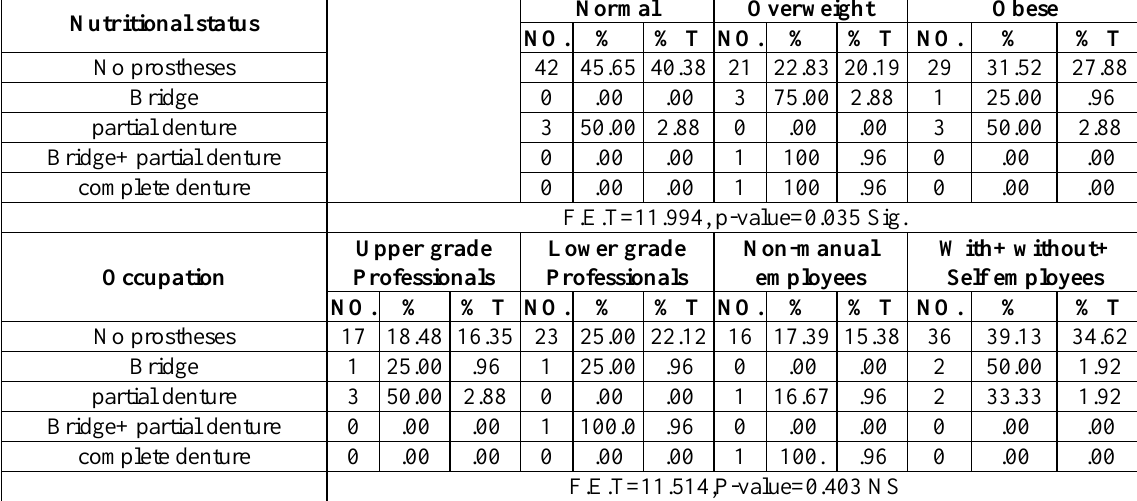
Table 4: Distribution of prosthetic status in lower arch by nutritional status and occupation. Nutritional